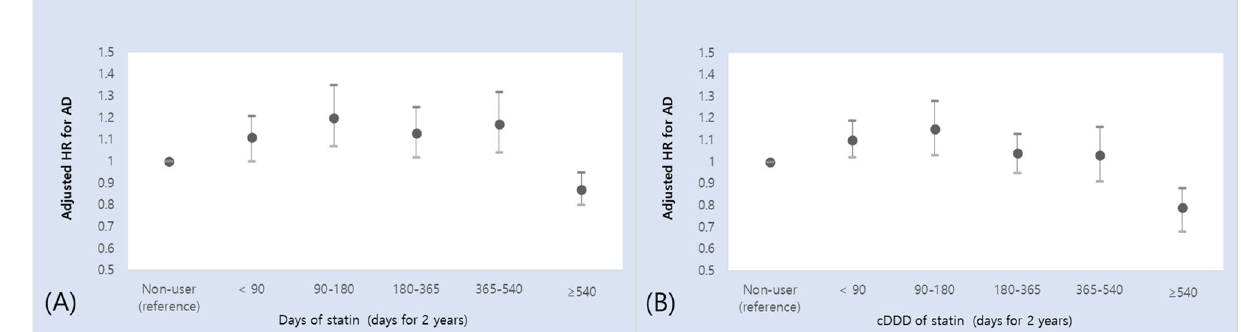
Figure 1. Association between statin use and incidence of Alzheimer’s disease (AD). Adjusted hazard ratios (HRs) for AD according to ( A ) duration of stain use and ( B ) cumulative defined daily dose (cDDD) for each 2-year period are shown. Statin use (≥ 540 days or cDDD) was associated with reduced risk of AD, while statin use (< 540 days or cDDD) was associated with increased risk of AD compared to statin non-use. Statin exposure by cDDD and incidence of AD showed an inverse J-shaped association with a significant P for trend among statin users (P-trend <